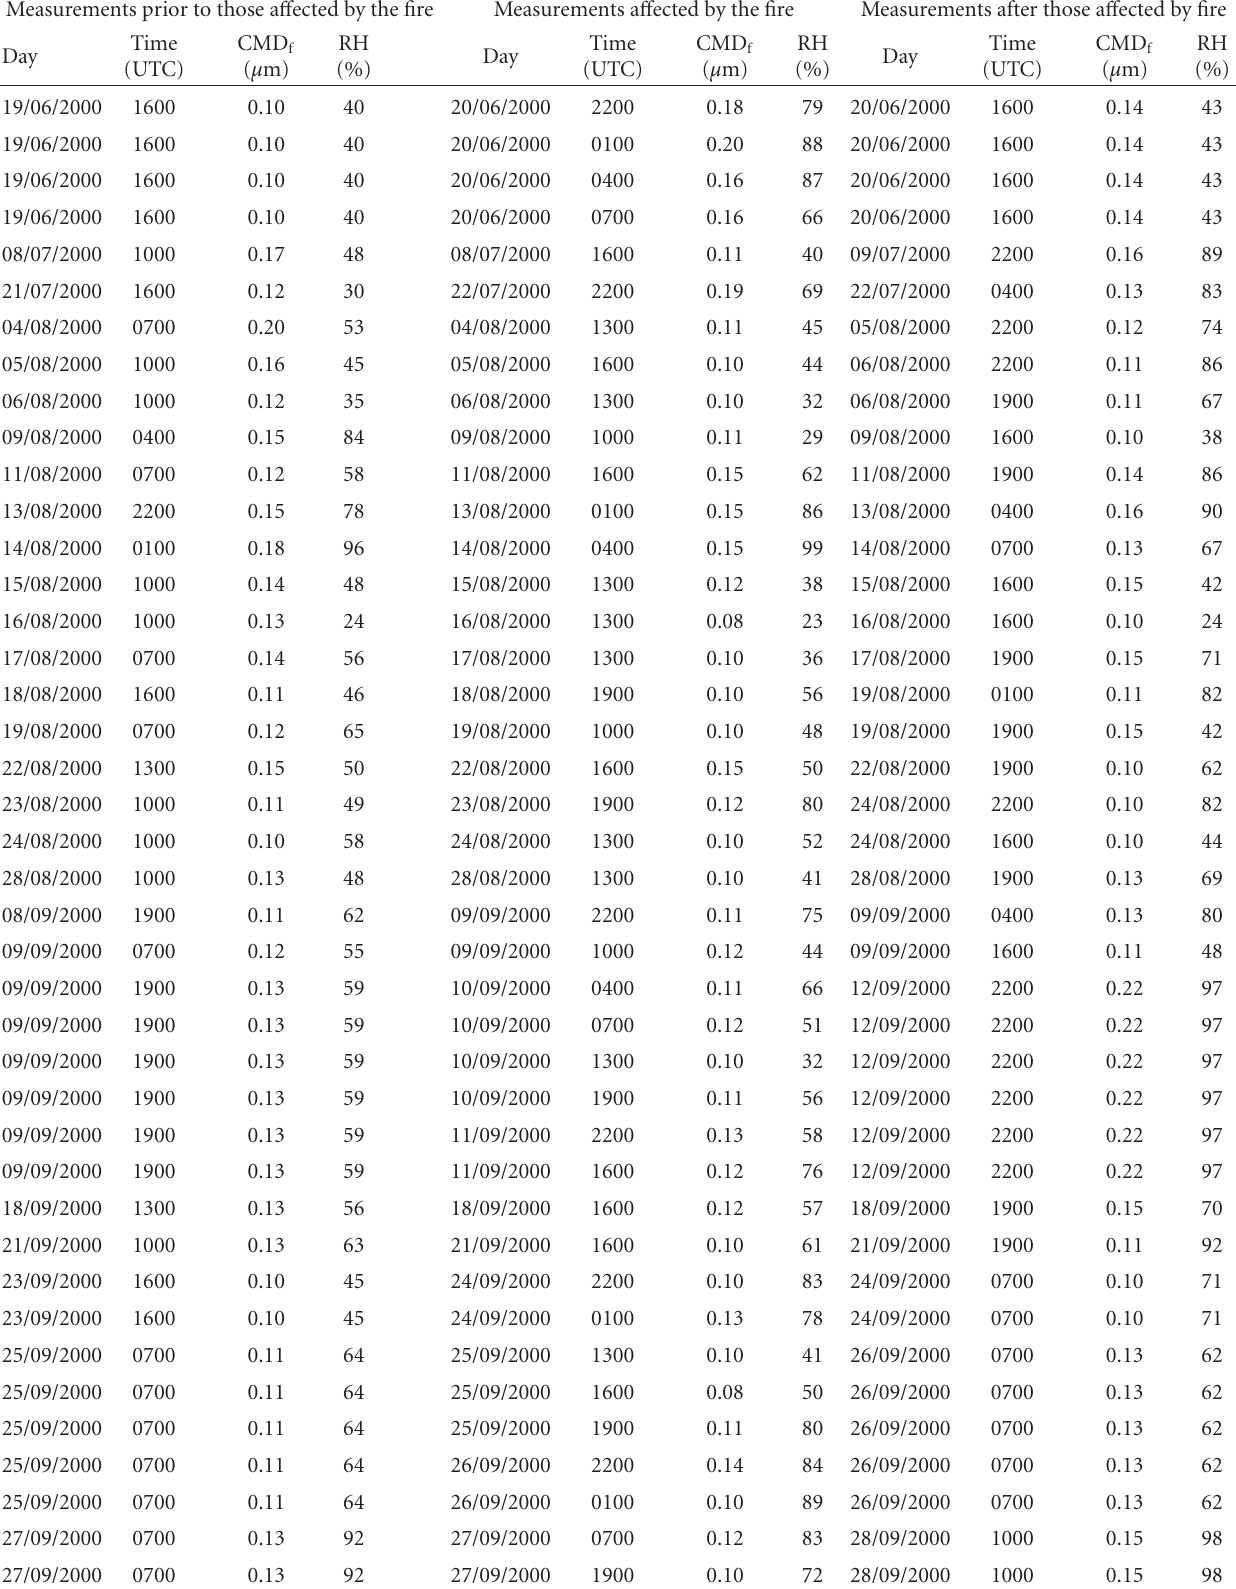
Table 7: Count median diameter of the fine mode (CMD f ) and relative humidity (RH) for the measurements before the fire, the ones a ff ected by the fire and the ones after the